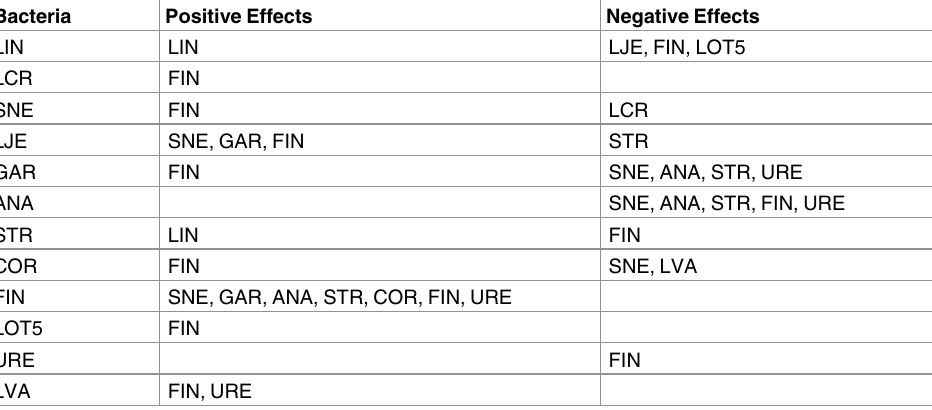
Table 3. Interactions among bacteria for subject 15. See legendfor Fig 1 for OTU abbreviations.